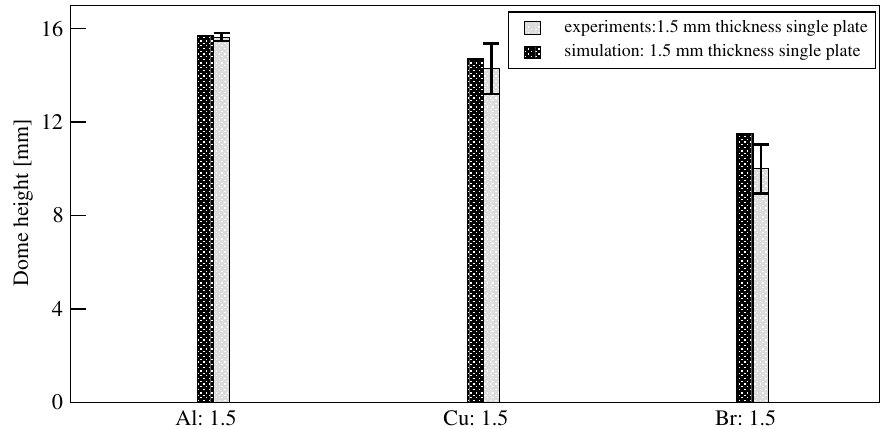
Figure 7. Comparison of dome height of the deformed metal sheets of 0.5-mm thicknesses with different sequences in the experiments and numerical simulations.